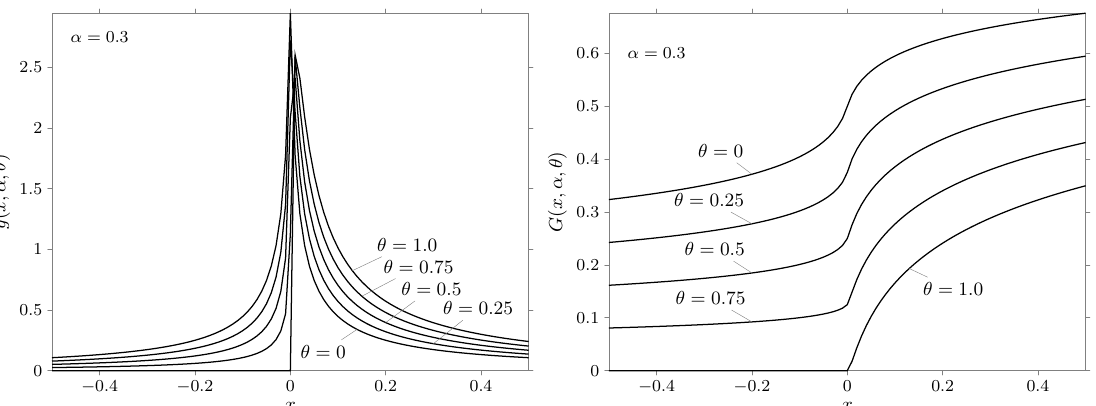
Figure 9. The probability density function g ( x , α , θ ) ( on the left ) and cumulative distribution function G ( x , α , θ ) ( on the right ) of a standard strictly stable law with α = 0.3 and specified values θ . α = 0 . 6